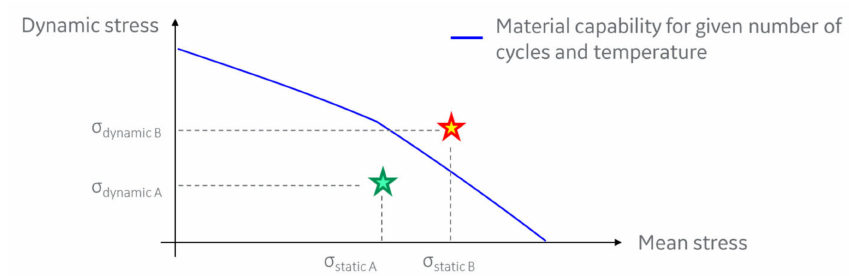
Figure 3. Notional Goodman